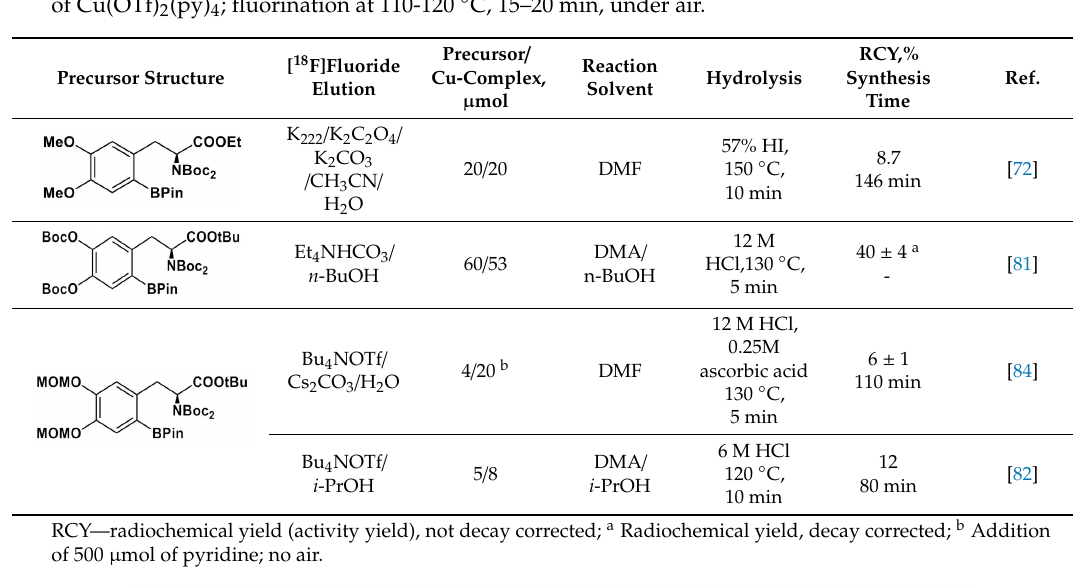
Table 2. Synthesis of 6- l -[ 18 F]FDOPA via fluorination of di ff erent ArylBPin precursors in the presence of Cu(OTf) 2 (py) 4 ; fluorination at 110-120 ◦ C, 15–20 min, under